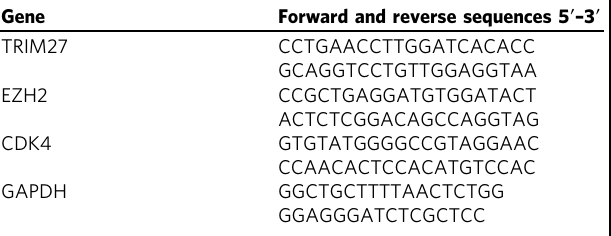
Respiration analysis . To measure OCR, cells were seeded into a 96 well plate overnight and dosed with indisulam, E7820 or vehicle control for 2h before the The wells were sealed with warm mineral oil and immediately read using the CLARIOstar plate reader (BMG Labtech) in continuous cycles for 3 h. Fluorescent lifetime ( μ s) was calculated using the CLARIOstar MARS data analysis software and OCR ( μ s, hour) was determined by calculating the maximum slope according to manufacturer ’ s instructions and pre-set analysis protocols from BMG Labtech.